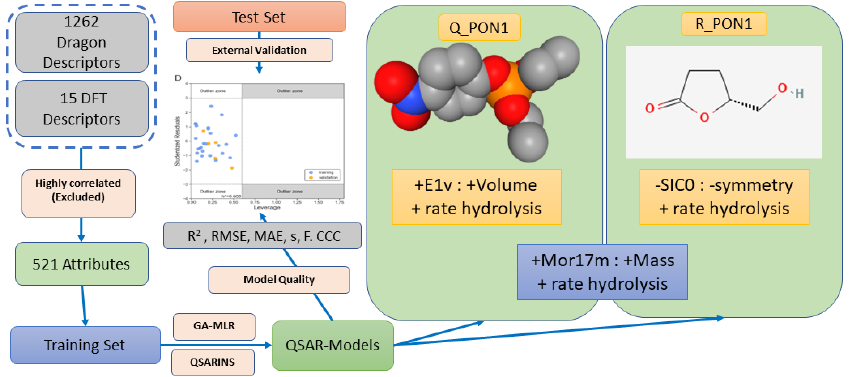
Figure 2. Schematic illustration of the QSAR modelling steps including descriptor generation, training and test sets created and GA-MLR modelling.